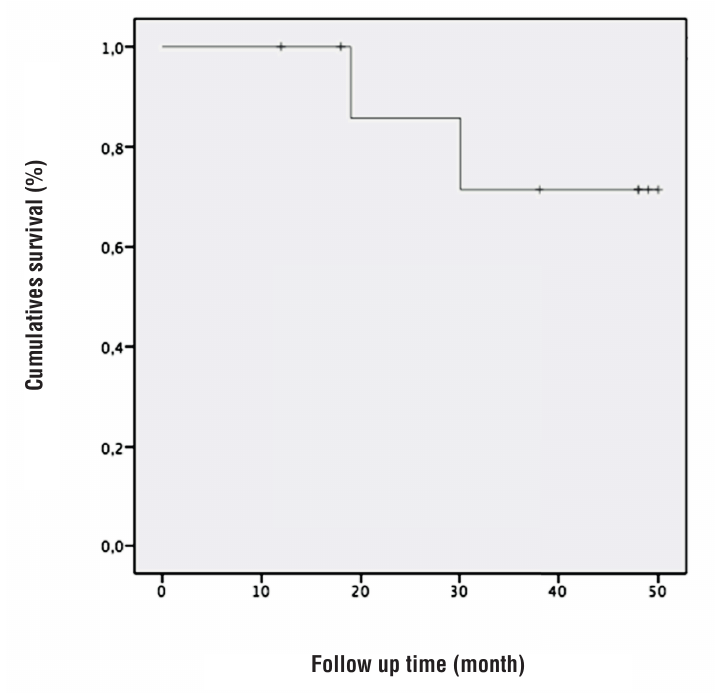
Figure 3 - Overall survival Kaplan-Meier curve